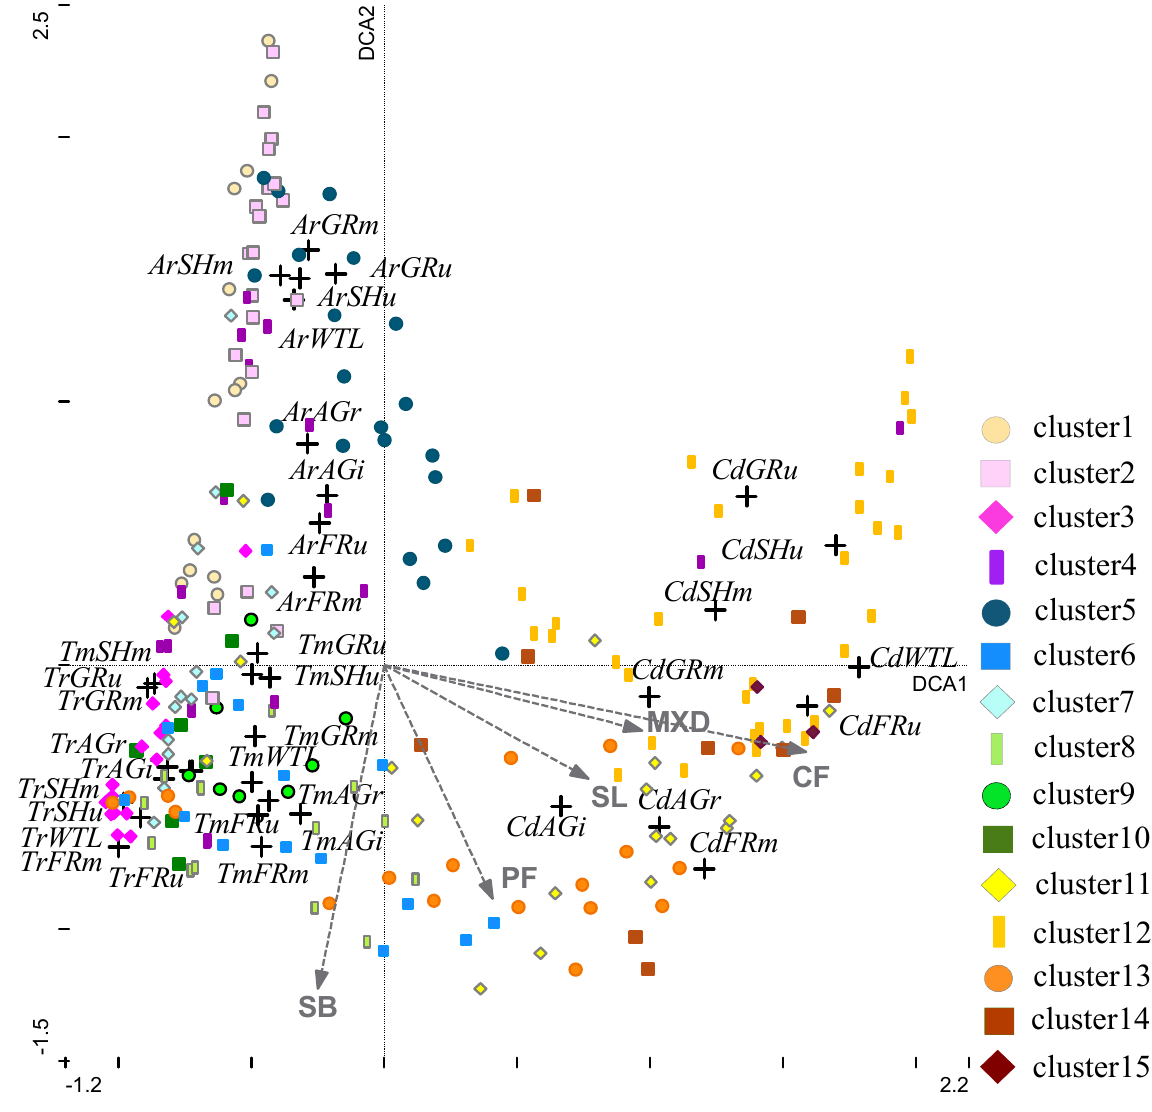
Figure 9. DCA triplot of the EFTs classified in 15 clusters (icons with colors) and the Land Use System classes (crosses). Arrows represent the phenological and productivity variables averaged within the EFTs. Their position indicates the correlation with the DCA